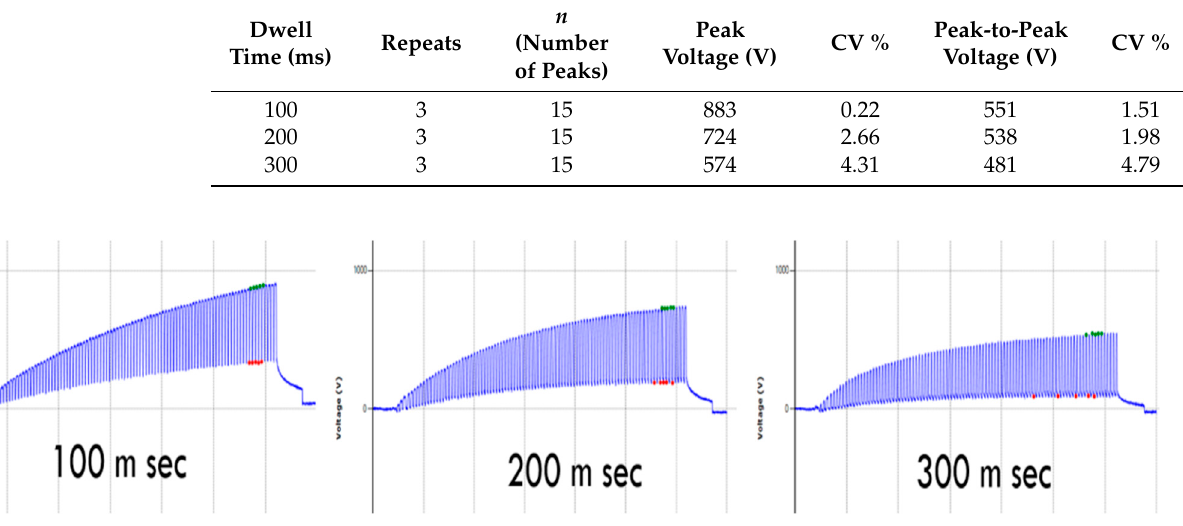
Table 6. Effect of sample size on the electrostatic charge generation.